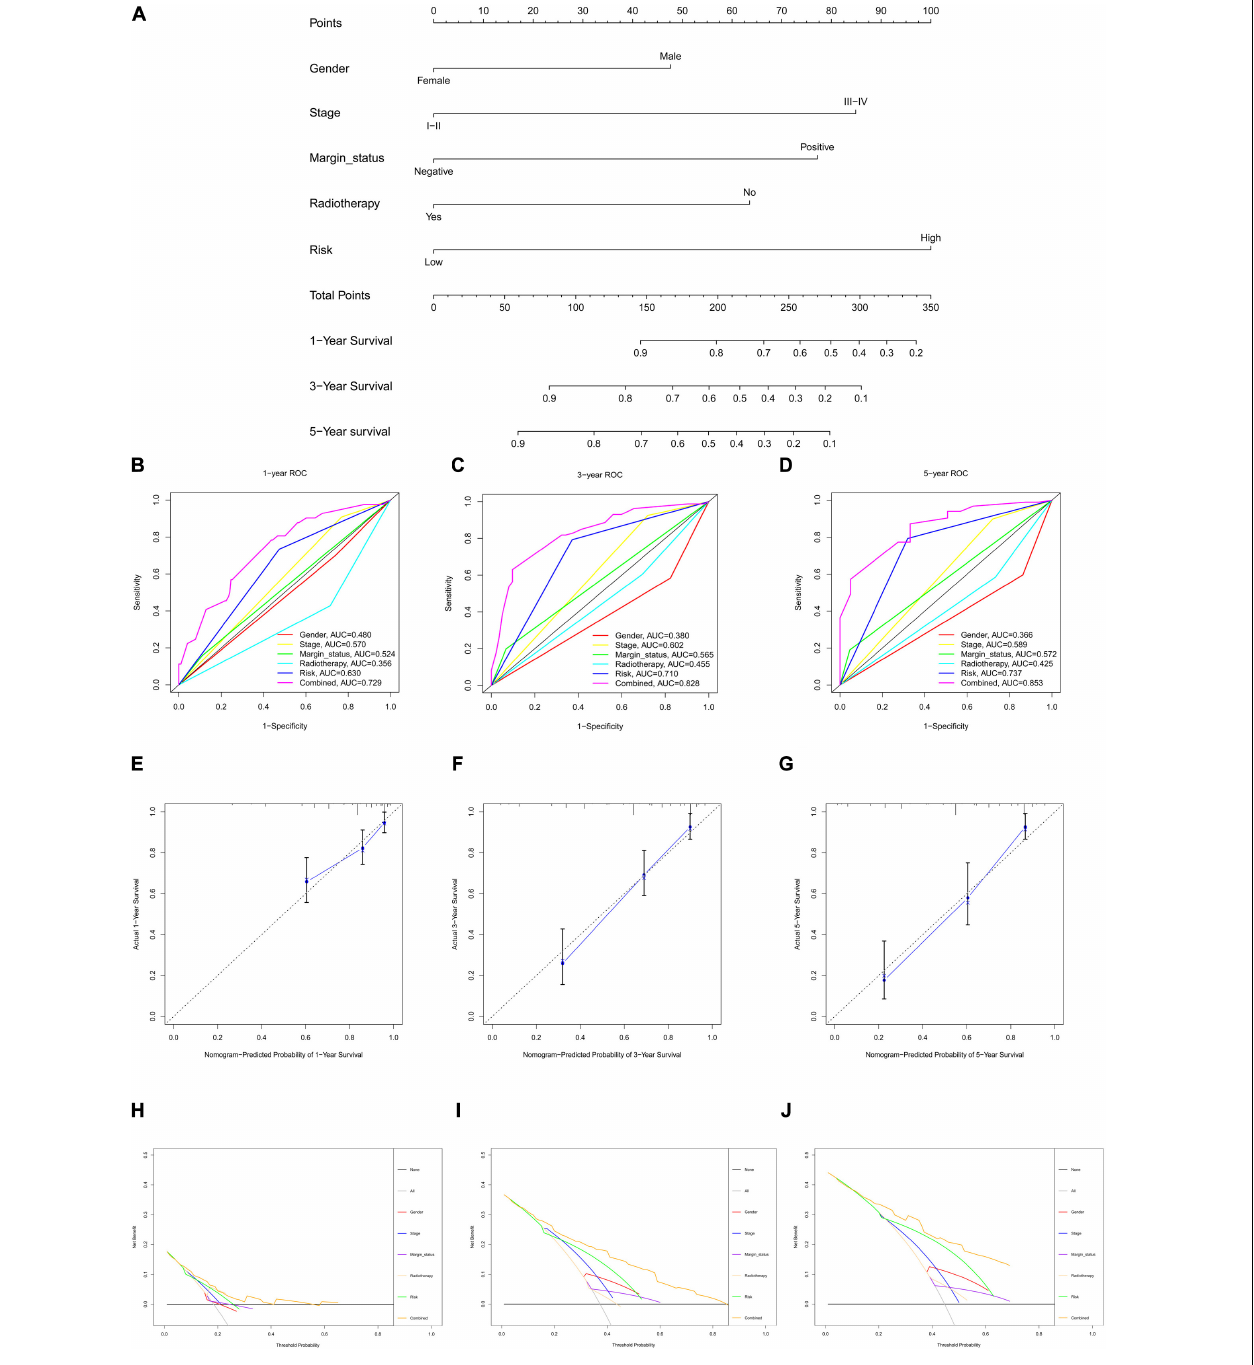
FIGURE 4 | Nomogram to predict 1-, 3-, and 5-year overall survival (OS) and its validation in HNSCC patients. (A) Nomogram to predict 1-, 3-, and 5-year OS of HNSCC patients. (B–D) ROC curves to assess nomogram accuracy to predict 1-, 3-, and 5-year OS in HNSCC patients. (E–G) Calibration plot analysis to assess nomogram accuracy of to predict 1-, 3-, and 5-year OS in HNSCC patients. (H–J) Decision curve analysis to assess nomogram accuracy to predict 1-, 3-, and 5-year OS in HNSCC